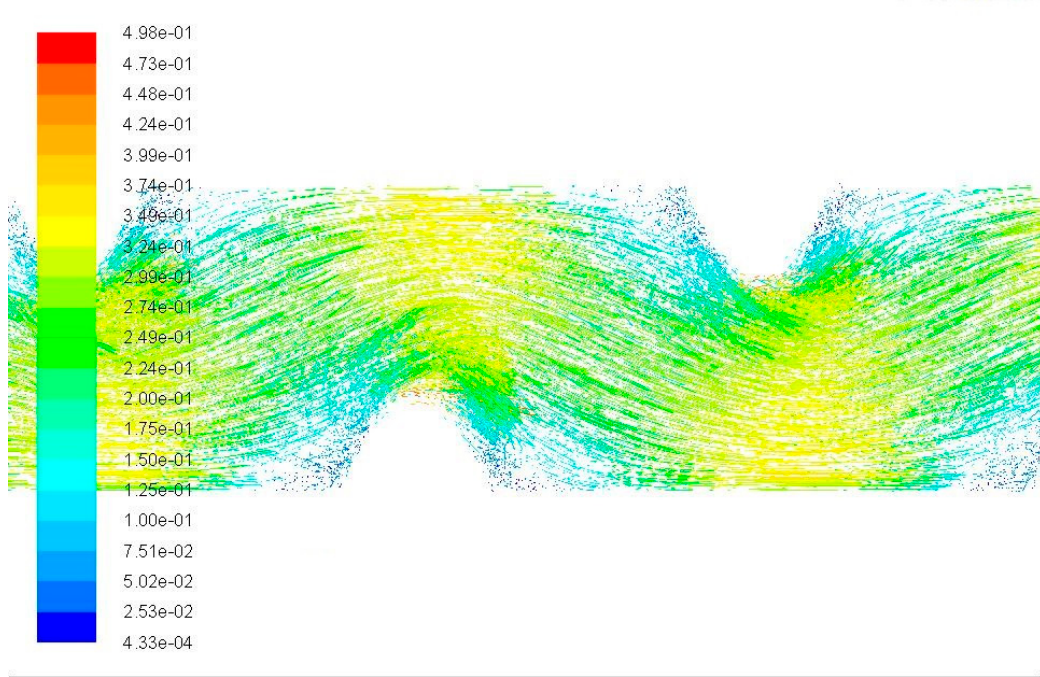
Figure 4. Streamlines and distribution of axial velocity (m/s) in a pipe with non-homogenous cross-